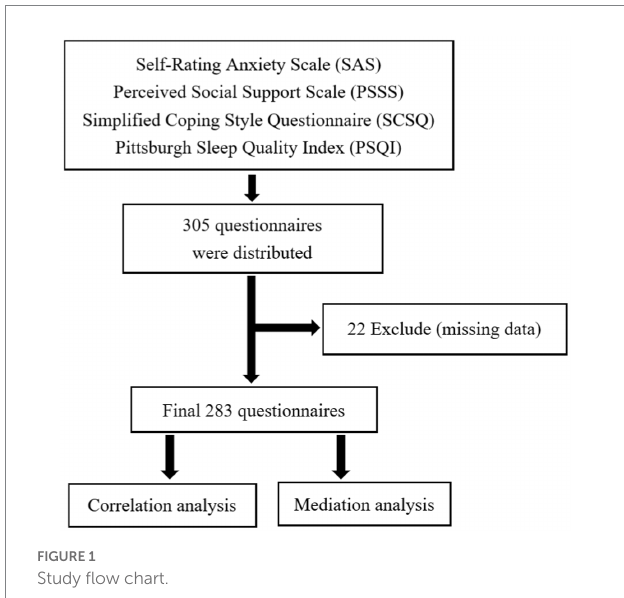
FIGURE 1 Study flow chart.